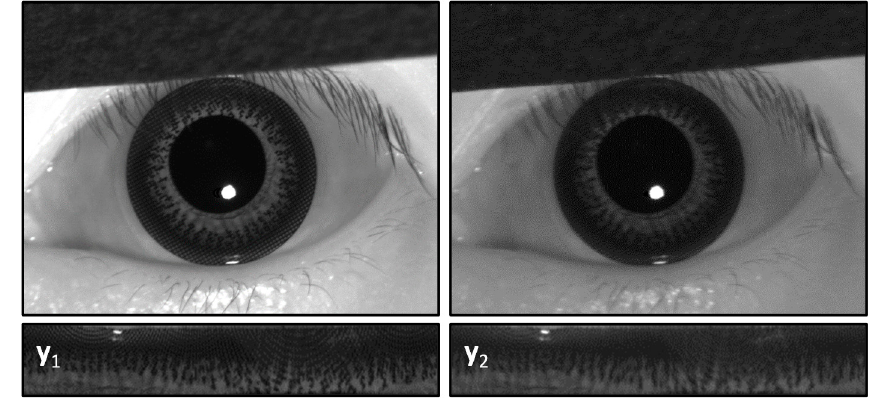
Figure 5. Iris images captured through the LP filter ( (cid:1877) (cid:2869) ) and HP filter ( (cid:1877) (cid:2870) ), respectively. At the current step, both mixed images are the combination of two source image, (cid:1876) (cid:3036)(cid:3045)(cid:3036)(cid:3046) and (cid:1876) (cid:3004)(cid:3004)(cid:3013) , with different ratio. The upper row is in Cartesian domain; and the lower row is in polar